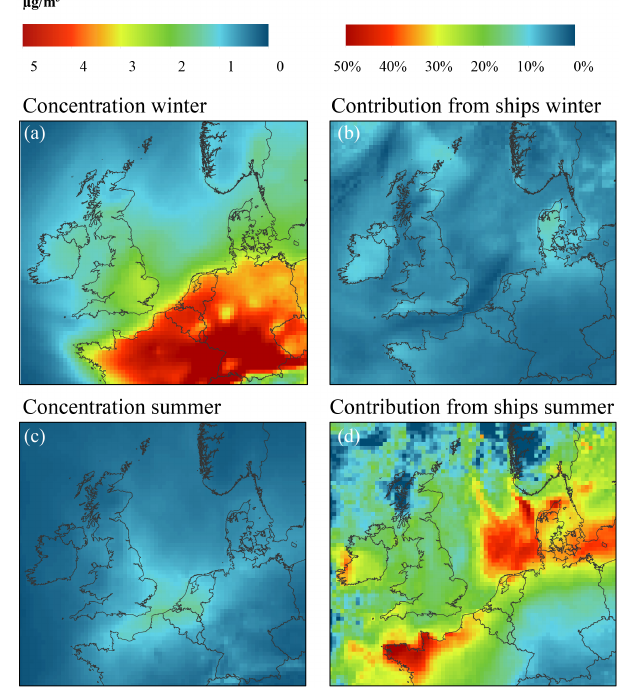
Figure 11. NO − in summer and winter and the relative contribution 3 of ship emissions.